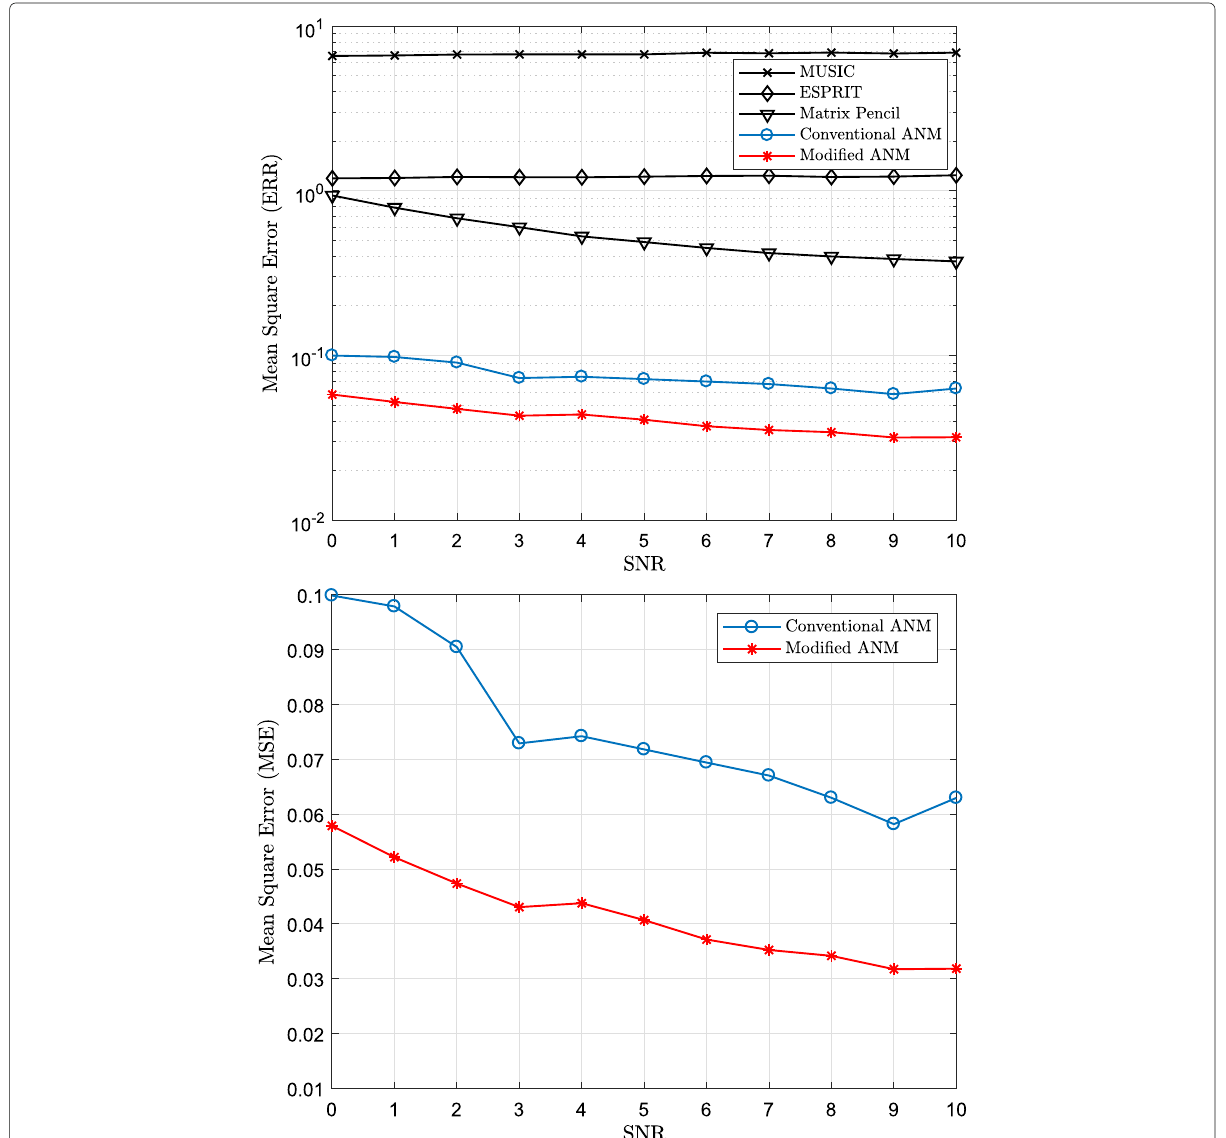
Fig. 6 MSE performance as a function of SNR. a MSE performance comparison of line spectrum estimation techniques as a function of SNR. b MSE performance comparison of ANM-based scheme as a function of